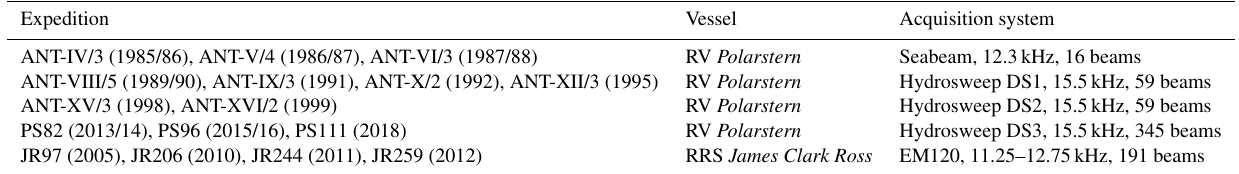
Figure 2. Mapped landform classes in the study area; for the location, see Fig. 1. Dots and crosses mark the locations of piston cores (PC) and gravity cores (GCs) (for core site details, see Supplement Table S1). Note that cores 13 and 3-7-1 are presumed to have been mislocated due to inaccurate positioning capabilities in the 1970s, when these cores were retrieved. Core site 3-7-1 is relocated by shifting it to the nearest location in the high-resolution bathymetry data that has the same water depth as measured at the core location. The red square indicates the area where seafloor images were taken by the Ocean Floor Observation System (OFOS; see Fig. S1). Table 1. Expeditions that collected investigated swath bathymetry data within the research area and the used acquisition systems. Expedition